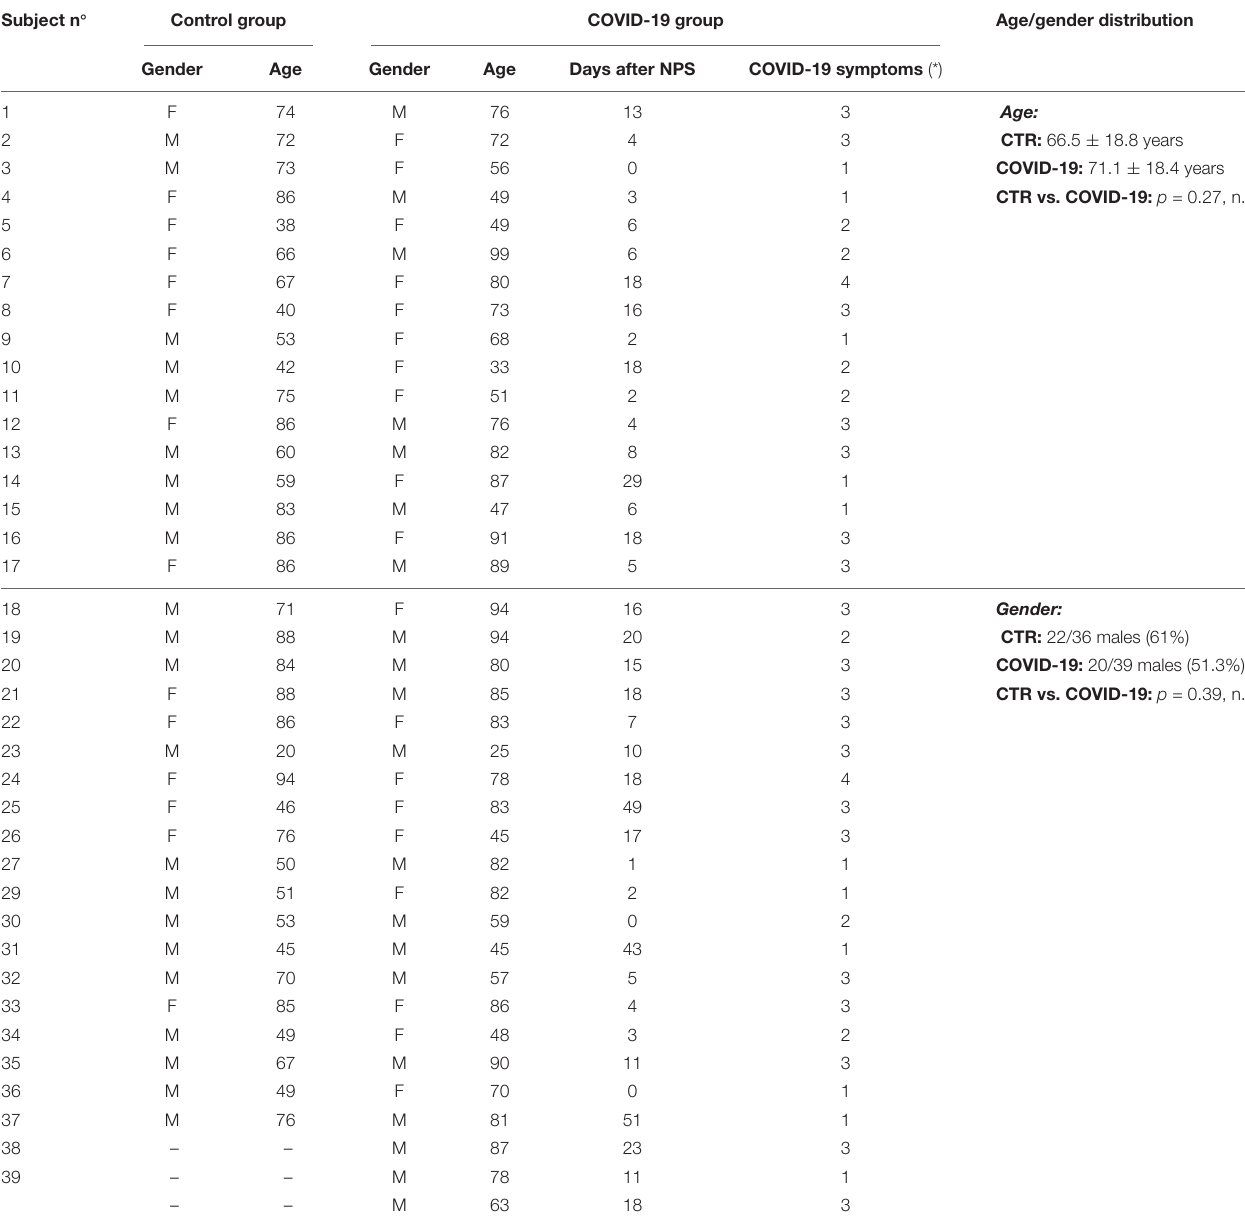
TABLE 1 | Characteristics of COVID-19 and control study